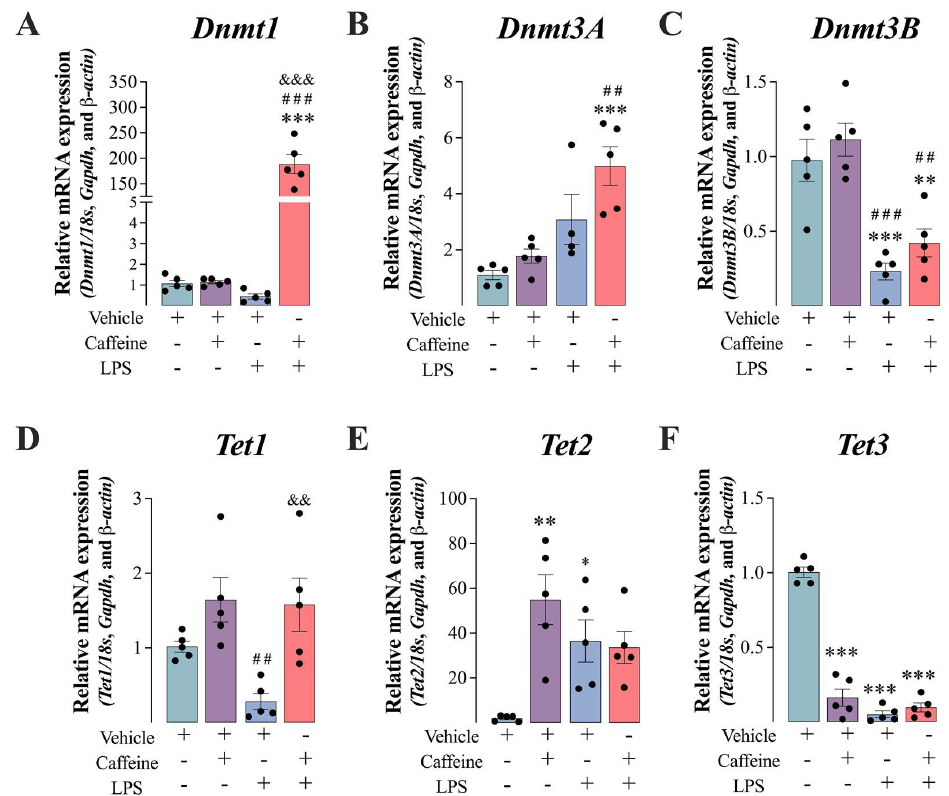
Figure 4. Caffeine plus lipopolysaccharide (LPS) administration induced de novo DNA